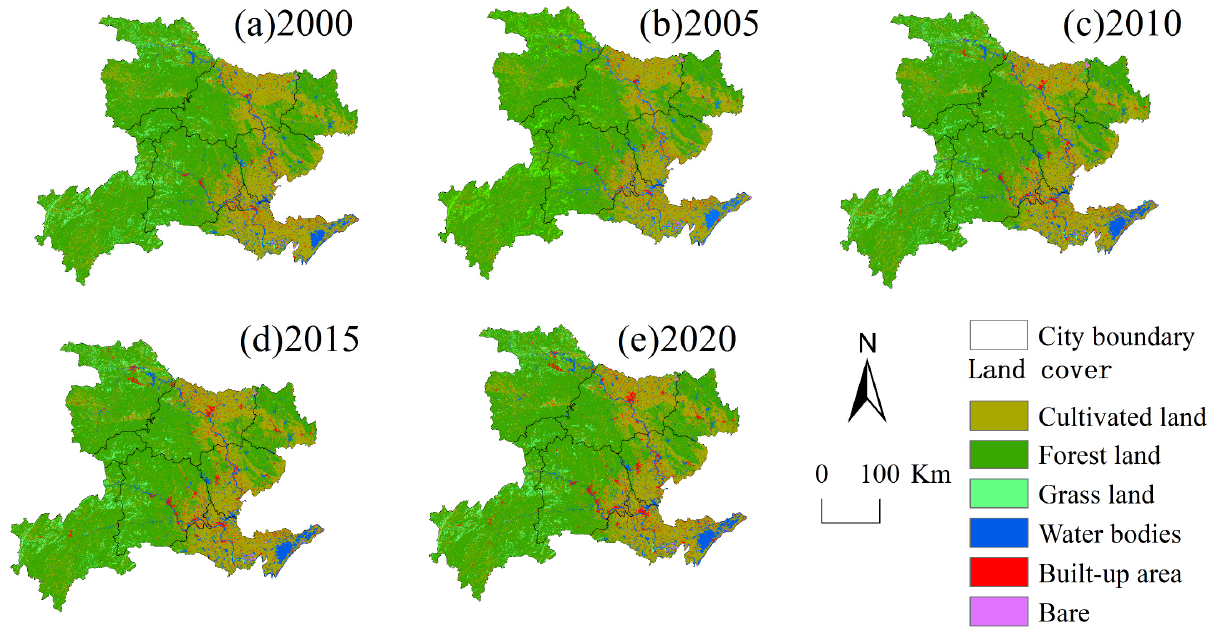
Figure 8. Land use map of western Hubei Province in ( a ) 2000, ( b ) 2005, ( c ) 2010, ( d ) 2015, ( e ) 2020.